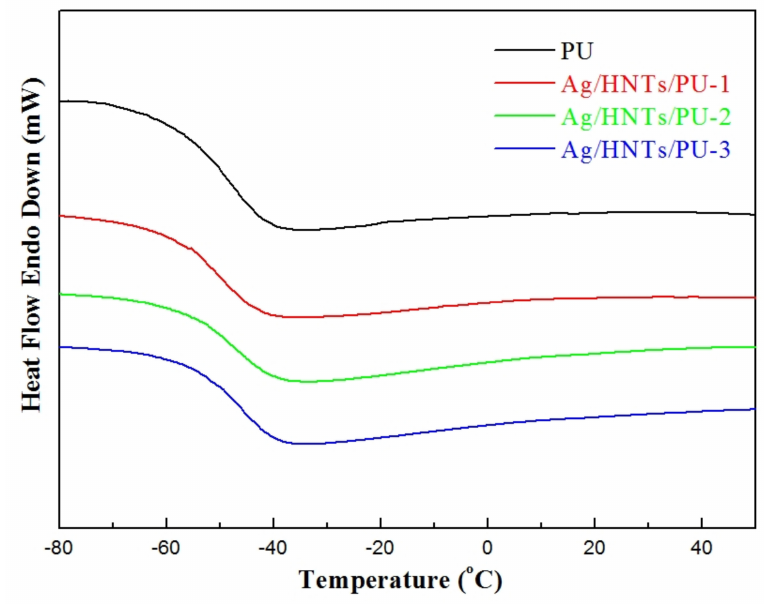
Figure 7. Di ff erential scanning calorimetry (DSC) thermograms of the Ag / HNTs /